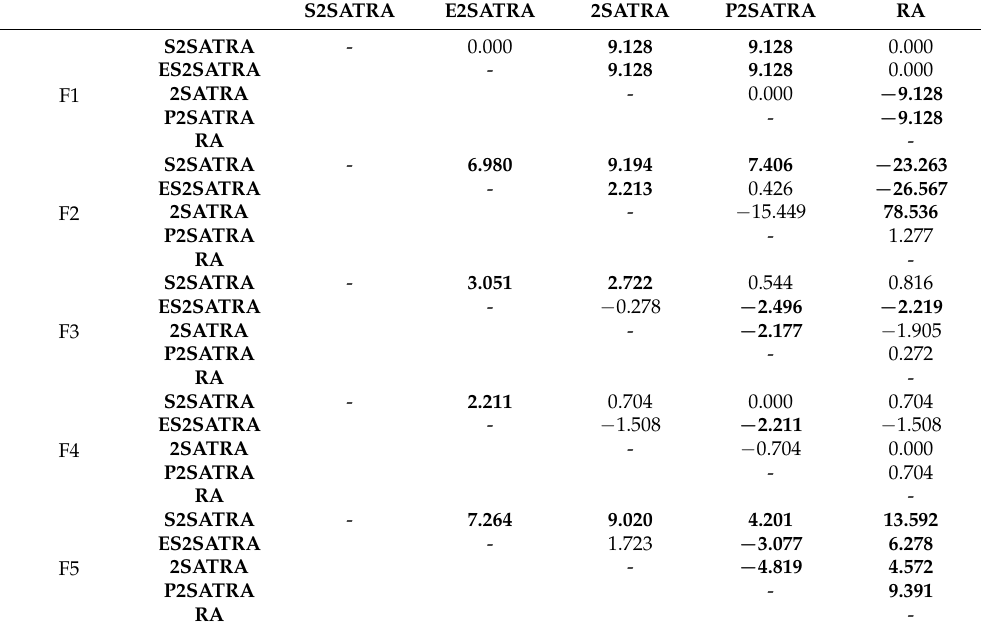
Table 14. McNemar’s statistical test for F1–F5.